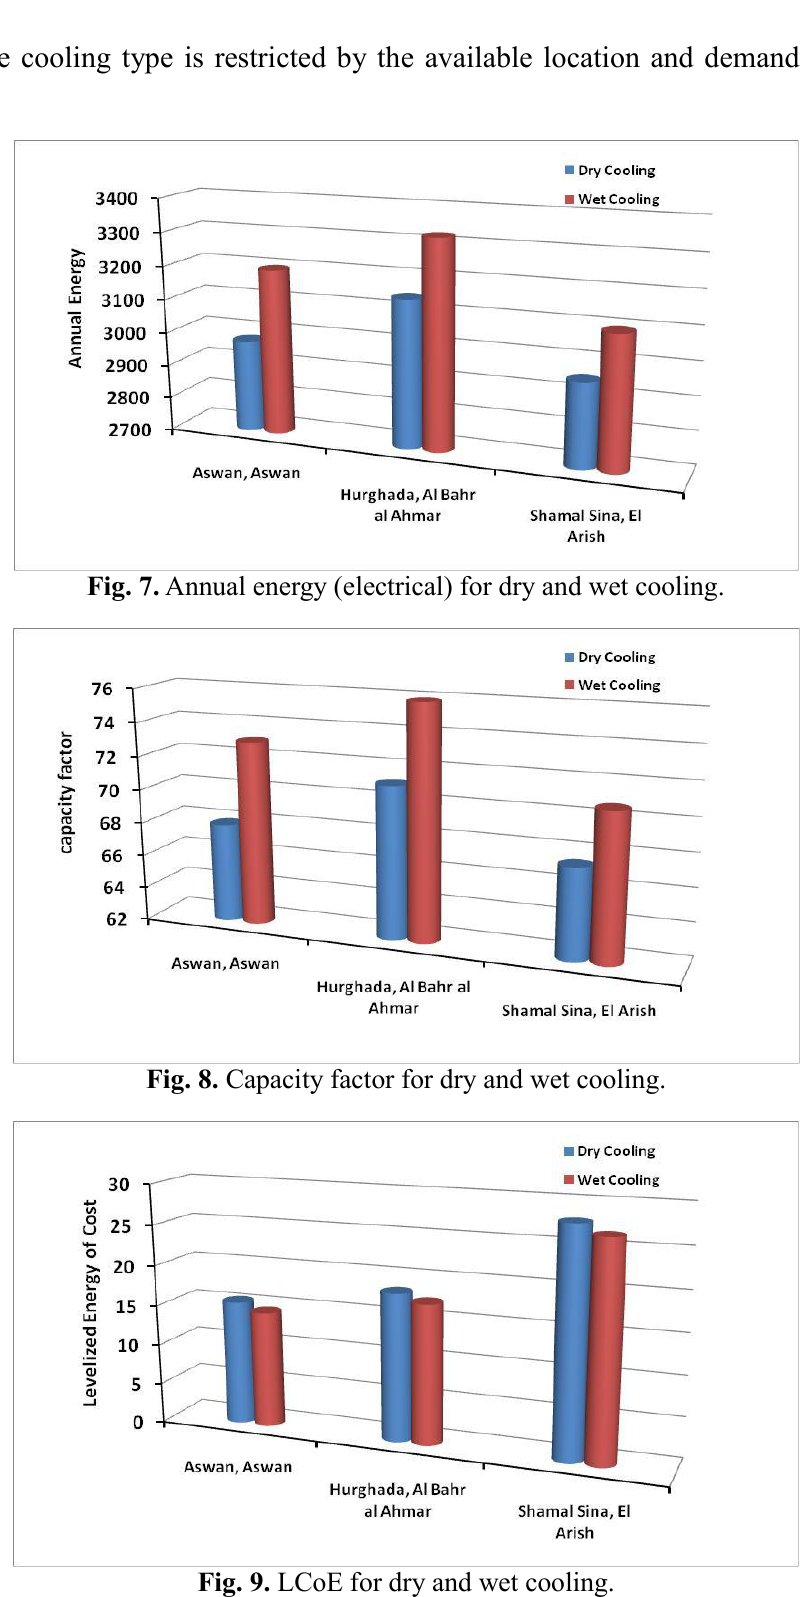
Fig. 9. LCoE for dry and wet